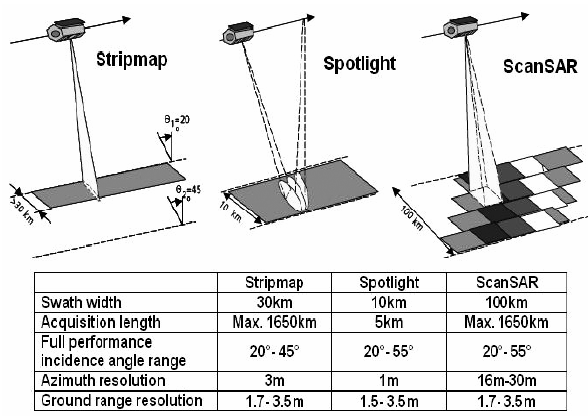
Figure 2. The TerraSAR-X geometries of imaging modes and their characteristics (Eineder et al. 2003)